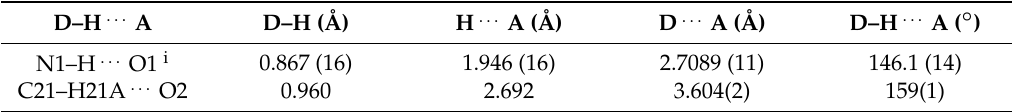
Figure 2. Partial crystal packing of 1 viewed along the c-axis with the N–H … O hydrogen bonds shown as dashed lines. Table 1. Selected hydrogen bond parameters of ( 1 ) (Å, ◦